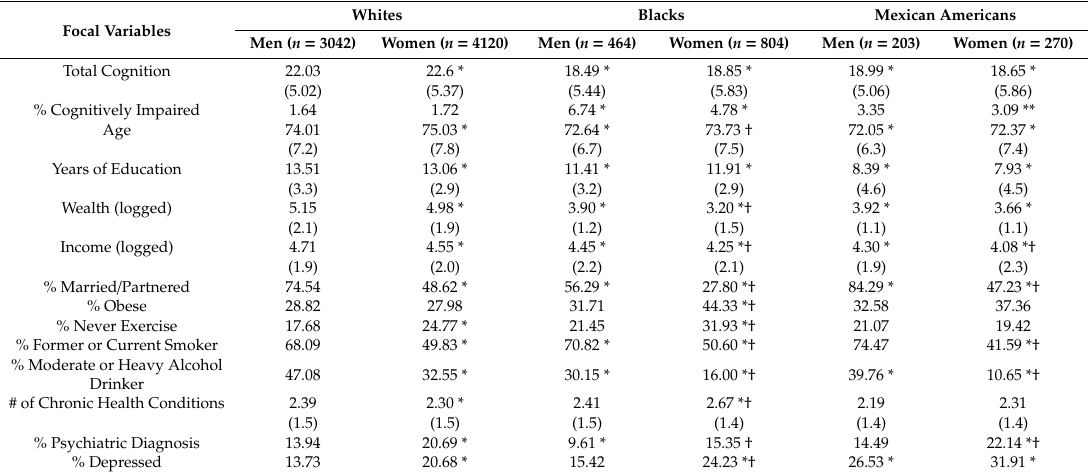
Table 1. Weighted descriptive statistics (proportions and means) of adults aged 65 and older by race / ethnicity and gender, Health and Retirement Study,